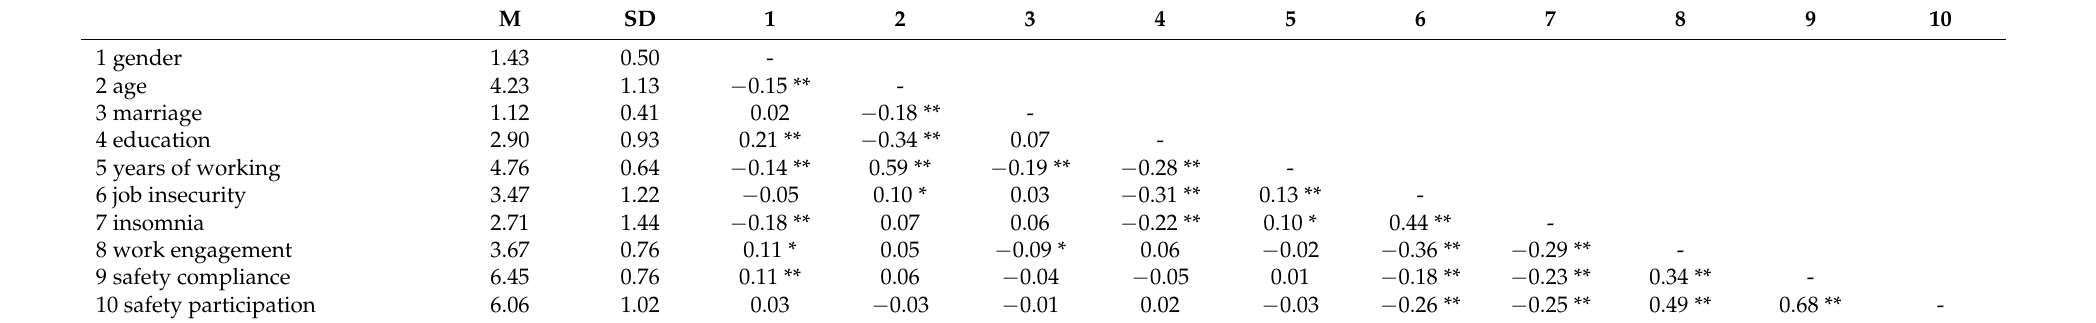
Table 2. Scale descriptive statistics and correlations among study variables (N = 568).